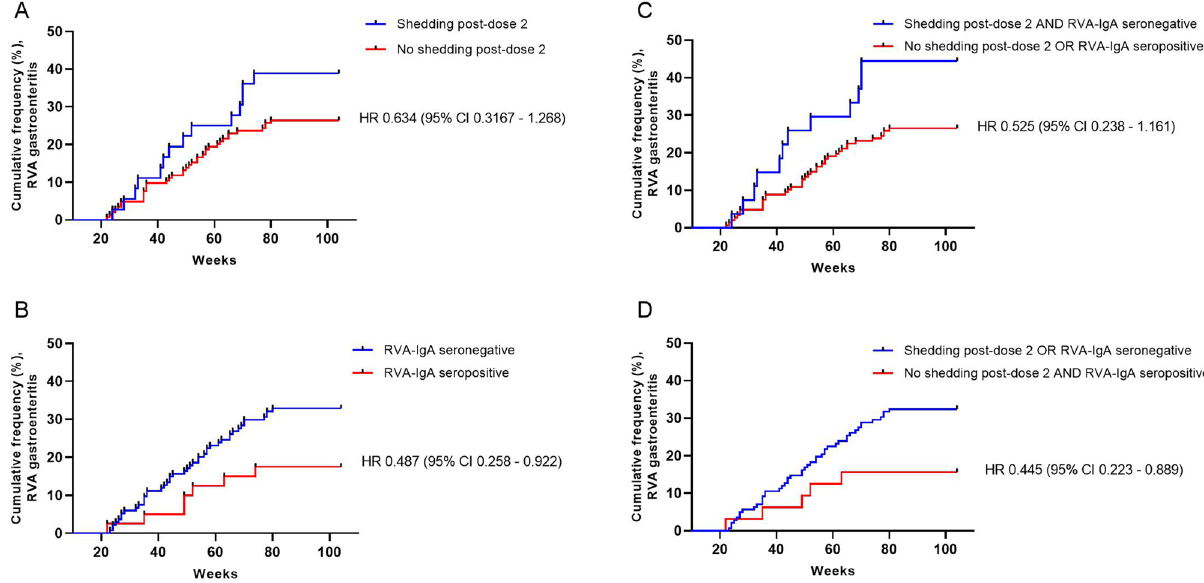
Figure 1. Time to first episode of RVA diarrhea among vaccinated infants 18–104 weeks of life. ( A ) Kaplan– Meier curve of time to first episode of RVA diarrhea in children with (blue line) or without (red line) fecal RVA shedding following Rotarix dose 2. ( B ) Kaplan–Meier curve of time to first episode of RVA diarrhea in children who were RVA-IgA seronegative (< 20 U/mL, blue line) or seropositive (≥ 20 U/mL, red line) at week 18 of life. ( C ) Kaplan–Meier curve of time to first episode of RVA diarrhea in children with both fecal RVA shedding following Rotarix dose 2 and who were RVA-IgA seronegative (blue line) or children who either inhibited fecal RVA shedding following Rotarix dose 2 or were RVA-IgA seropositive (red line). ( D ) Kaplan–Meier curve of time to first episode of RVA diarrhea in children with fecal RVA shedding following Rotarix dose 2 or who were RVA-IgA seronegative (blue line) or children who both inhibited fecal RVA shedding following Rotarix dose 2 and were RVA-IgA seropositive (red line). CI confidence interval, HR hazard ratio. Kaplan–Meier